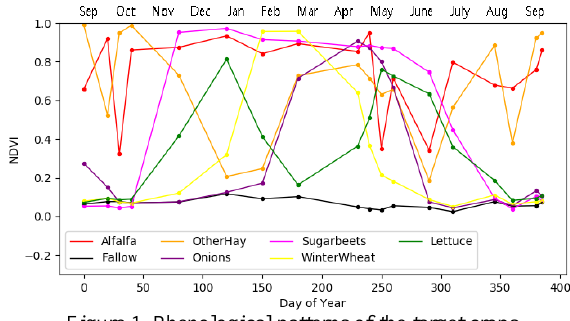
Figure 1. Phenological patterns of the target